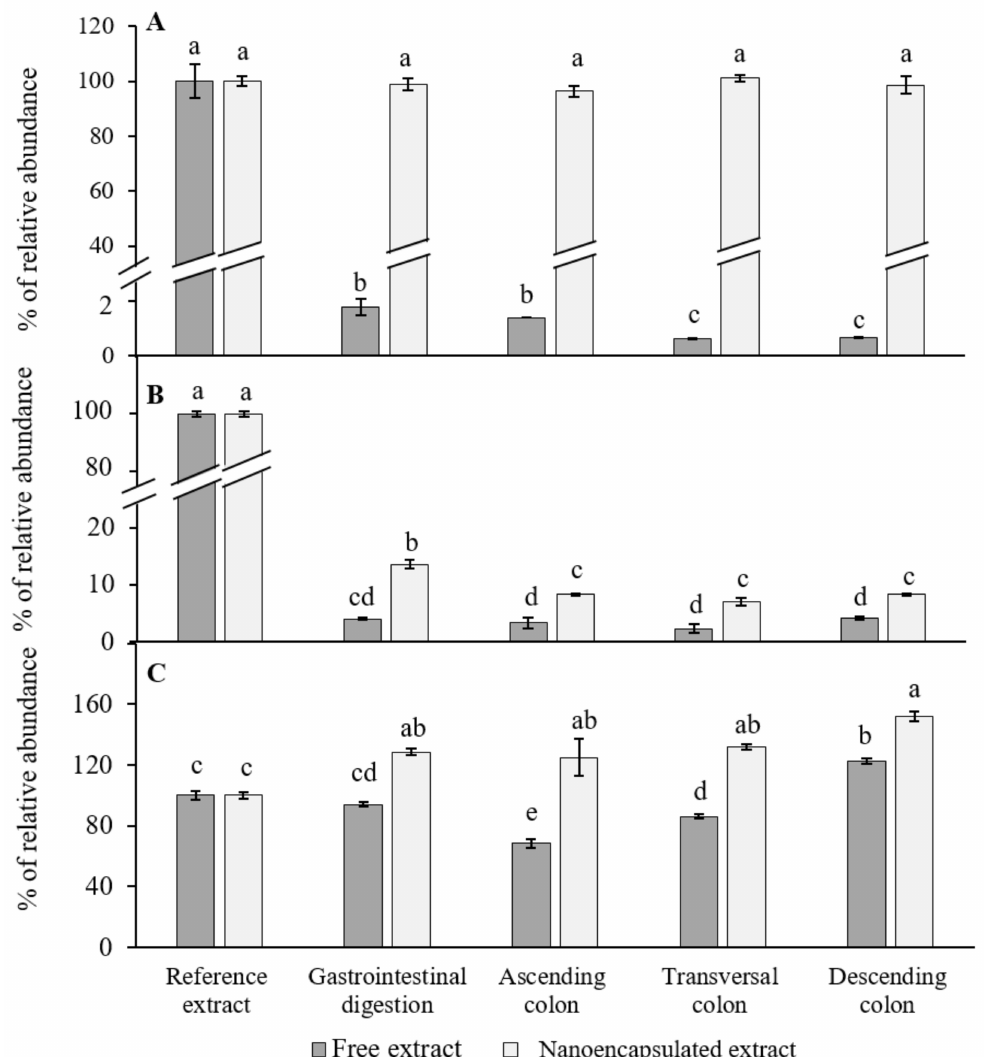
Figure 1. Percentage of the relative abundance of ( A ) sulforaphane (SFN), ( B ) indole-3-carbinol, and ( C ) iberin, when feeding the dynamic colonic-gastrointestinal digester (D-CGID) with the red cabbage aqueous extract, both free and nanoencapsulated ( n = 3 ± SE). The reference extract was taken as 100% and a two-way ANOVA analysis with an HSD Tukey’s test as a post hoc test was performed. Different letters indicate statistically significant differences ( p <